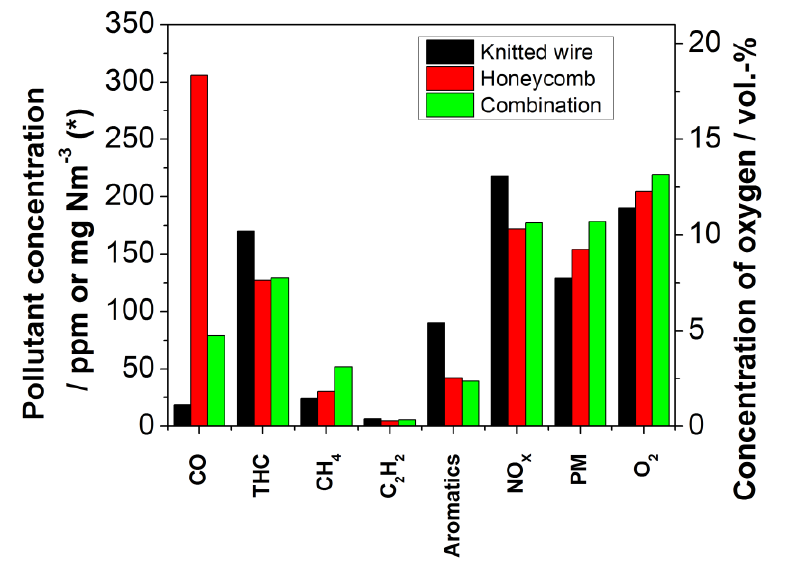
Figure 11. Comparison of the concentrations of selected pollutants and oxygen in the exhaust stream after the catalyst (black bars: knitted wire catalyst; red bars: honeycomb catalyst, green bars: combination of honeycomb and knitted wire catalyst; * The measurement unit of the particulate matter concentration is mg Nm −3 and for all other pollutants